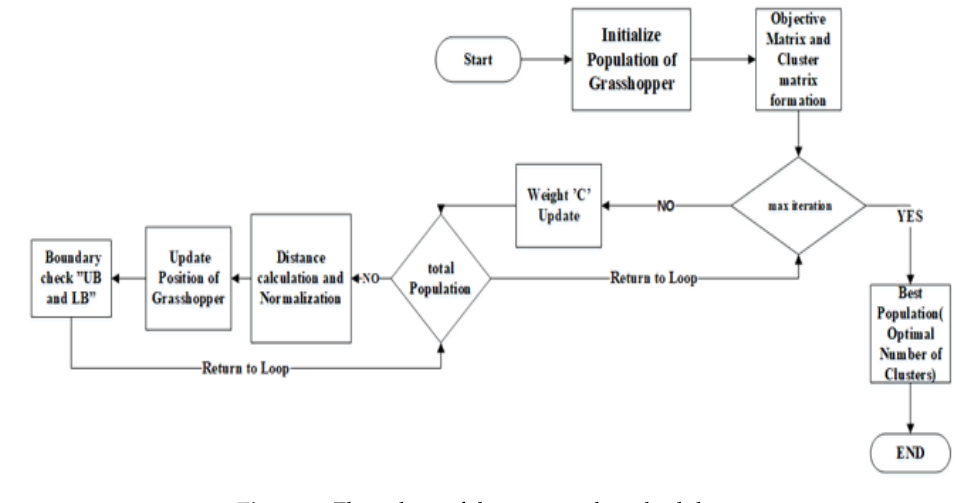
Figure 3. Flow chart of the proposed methodology.